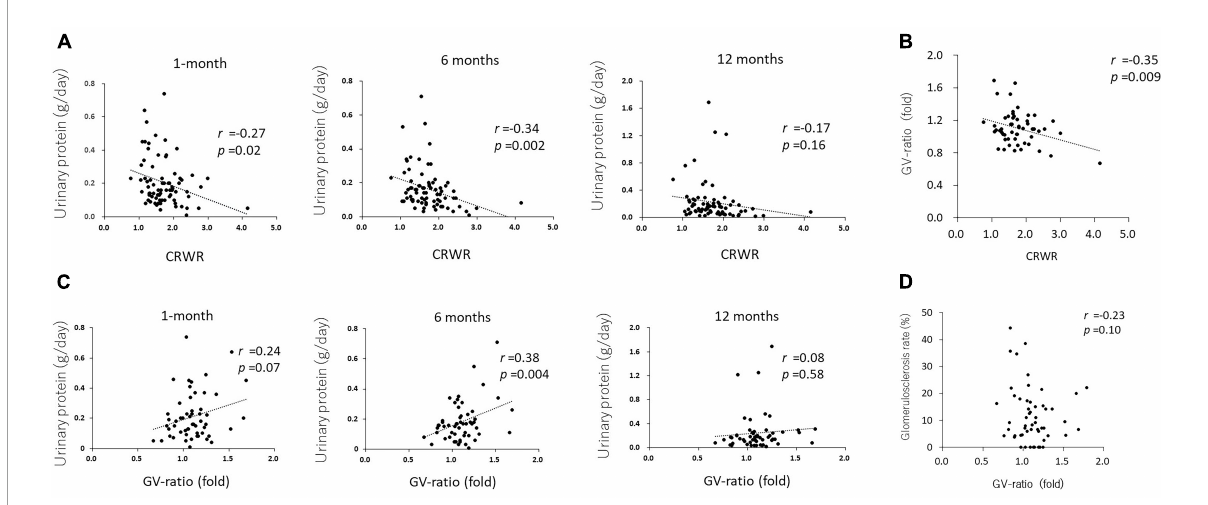
FIGURE3 Correlation between CRWR and GV-ratio and urinary protein. (A) Correlation between CRWR and urinary protein at 1, 6, and 12 months posttransplantation. (B) Correlation between CRWR and GV-ratio. (C) Correlation between GV ratio and urinary protein at 1, 6, and 12 months posttransplantation. (D) Correlation between GV ratio and the percentage of glomerular